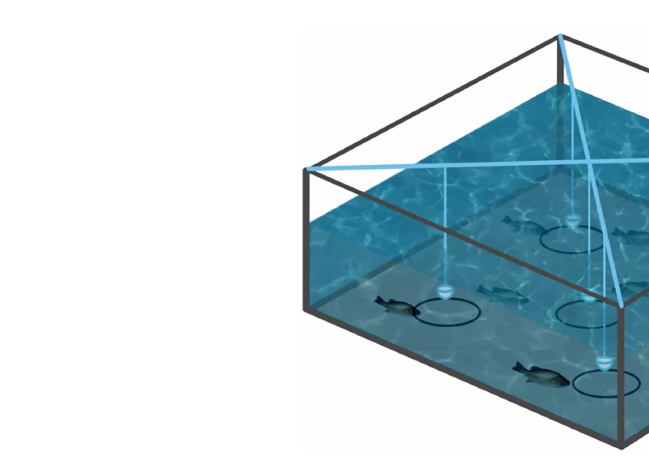
FIGURE 1 Schematic diagram of biting-balls test